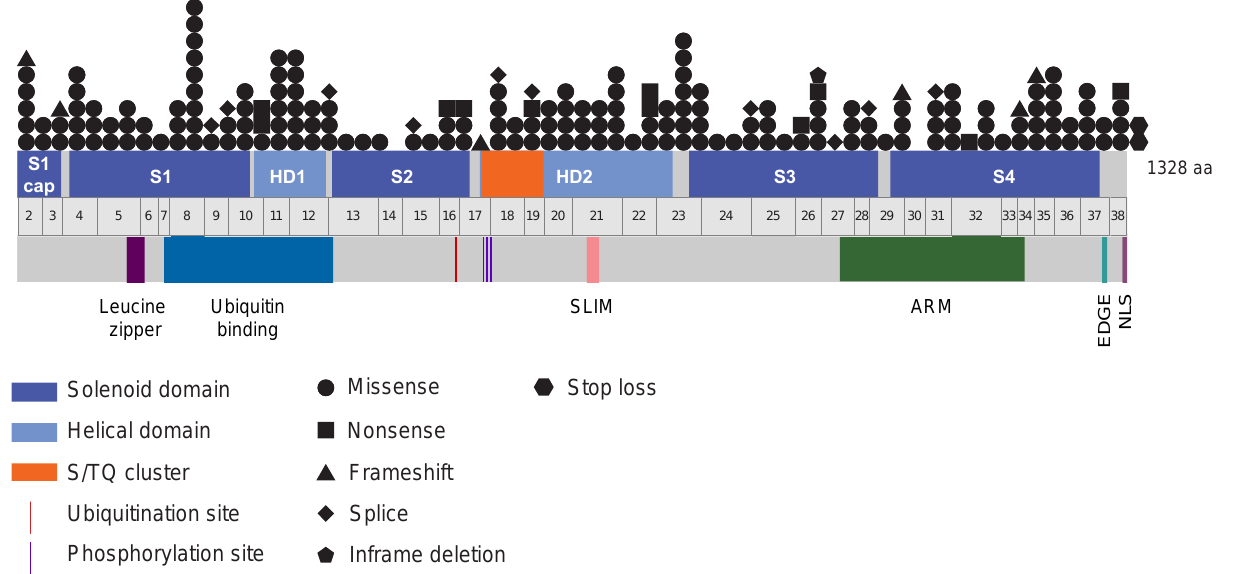
Figure 3. Schema showing the location of all somatic variants in the FANCI gene and protein identified in tumours from the TCGA PanCancer Atlas.